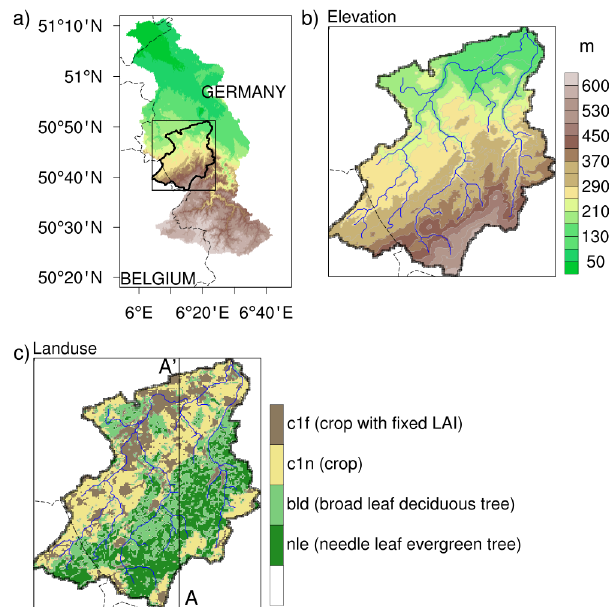
Figure 2. (a) Topography of the Rur catchment, which lies at the border of Germany, Belgium, Luxembourg and the Netherlands. (b) Topography of the sub-catchment of the Rur used in this study (catchment of the River Inde including the Wehebach tributary in the east), overlaid with the stream networks. (c) Land-use map of the sub-catchment.